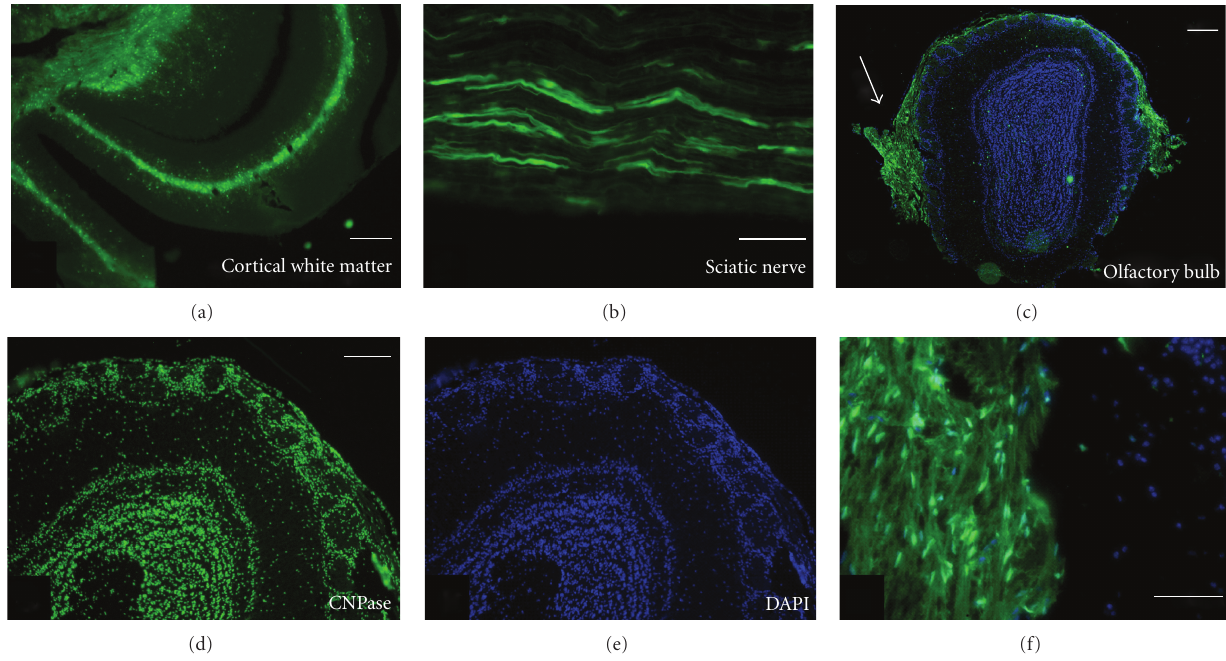
Figure 1: CNPase expression is characteristic of myelinating cells. (a) In the transgenic mouse where GFP is under the control of CNPase, GFP expression can be observed in cortical white matter (a) and sciatic nerve (b). The GFP is present in oligodendrocytes in white matter of the CNS and Schwann cells in the peripheral nerve. (c) Cross-section of the olfactory bulb from the CNPase mouse showing GFP expression in the olfactory nerve (arrow) and the outer nerve layer of the olfactory bulb (OB) where OECs are present as the only glia cell type. (f) Higher power image of the olfactory nerve from (c) showing GFP expression in the nuclei and cytoplasm of OECs in the outer nerve layer. (d) and (e) Immunohistochemistry for CNPase in a wild type mouse OB showing CNPase expression in deep white matter and outer margins of the bulb. Note that the round glomeruli are devoid of CNPase. Nuclei have been counterstained with DAPI (blue) in (c), (e), and (f). Scale bars: (a) = 8 µ m, (b) = 12 µ m, (c) = 500 µ m, (d) = 150 µ m and pertains to (d) and (e), (f) = 3 µ